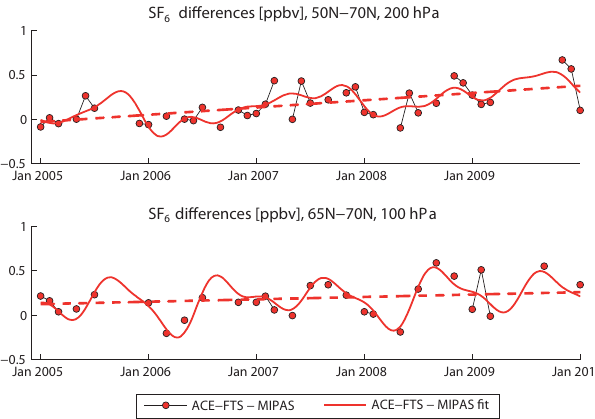
Figure 11. Time series of zonal monthly mean SF 6 absolute dif- ferences between ACE-FTS and MIPAS (black lines, red symbols) are given for 2005 to 2010 at 50–70 ◦ N on 200 and at 65–70 ◦ N at 100hPa. Additionally, the calculated fit (solid colored line) and the corresponding linear term (dashed colored line) are